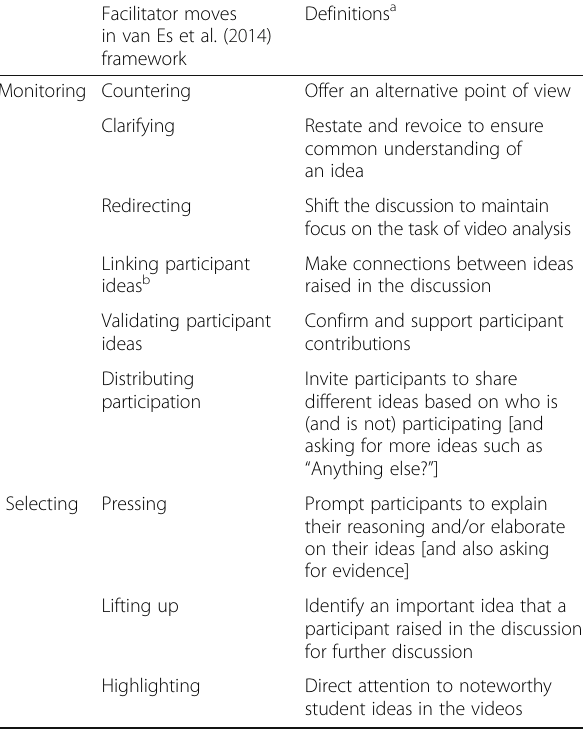
Table 2 Grouping of facilitator moves under “ monitoring ” and “ selecting ” practices Facilitator moves in van Es et al.